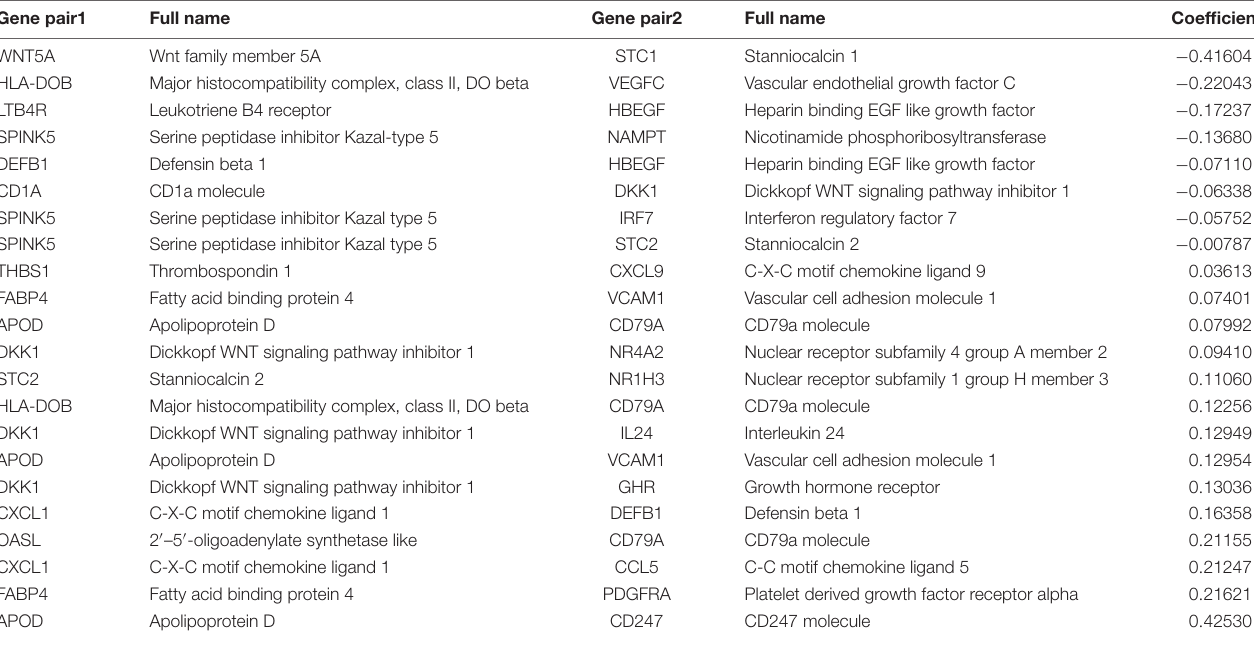
TABLE 2 | Information on the 22 immune-related gene pairs and the coefficient in